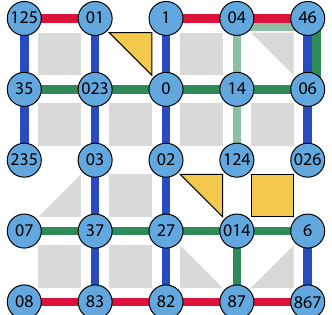
FIG. 4. An example of an optimized set of explicitly enforced constraints (yellow). The optimization aims at increasing the number of implicitly preserved three-body constraints (gray tri- angles) that cause the driver lines shown in green to deviate from straight-line shapes. The yellow square is a four-body constraint that is kept explicitly enforced to connect the adjacent explic- itly enforced three-body constraint to the boundary, simplifying the driver lines. One line is omitted as it can be obtained via symmetric difference of the others.